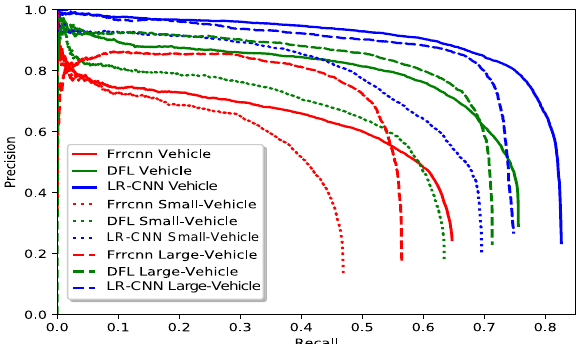
Figure 5. Precision-Recall curves given by different methods on the DOTA dataset. The color denotes the method while the line type denotes different tasks.